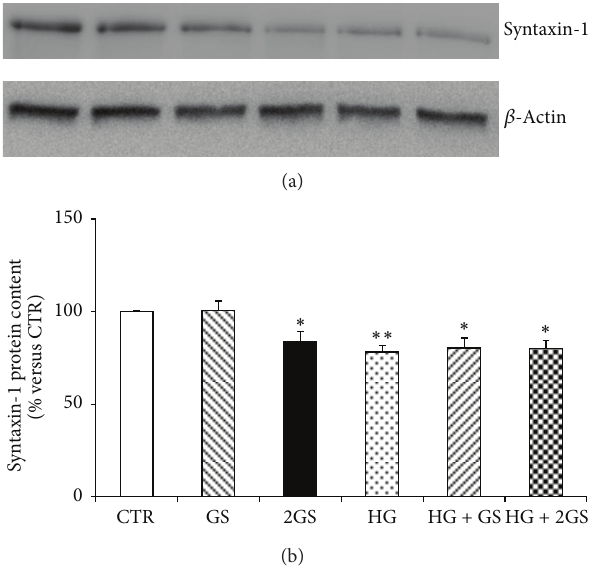
Figure 6: The higher concentrations of GS and HG decrease SYNTHAXIN-1 protein content. (a) Representative western blot analysis. (b) Quantification of densitometries of western blot bands. Data were expressed as mean ± SE of fold induction relative to 𝛽 - actin ( 𝑛 = 6 ). ∗ 𝑃 < 0.05 and ∗∗ 𝑃 < 0.01 versus